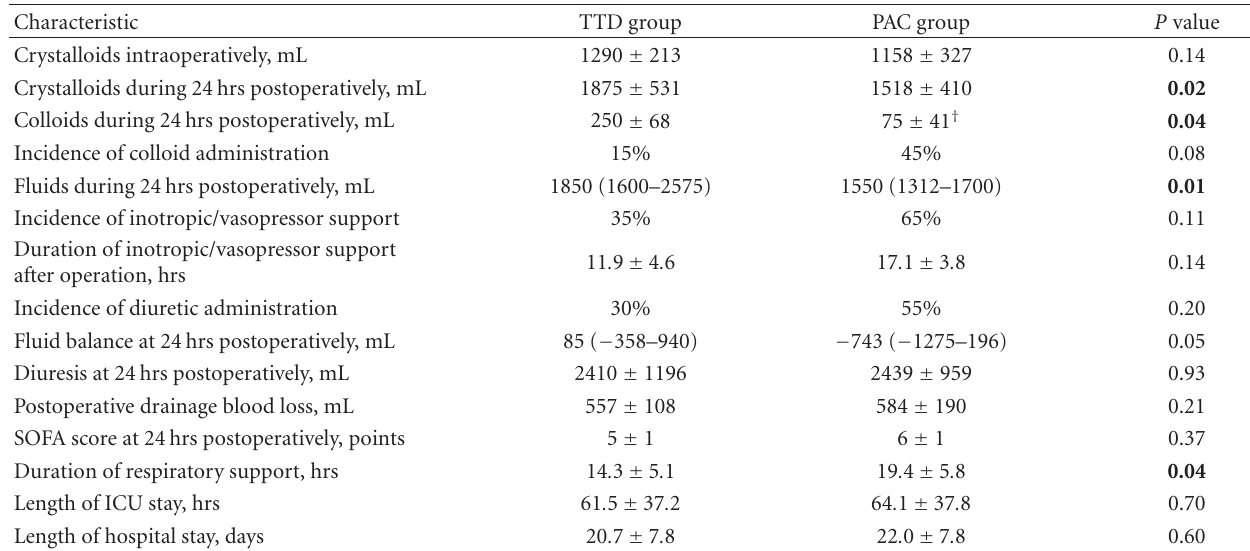
Table 4: Clinical characteristics of the study